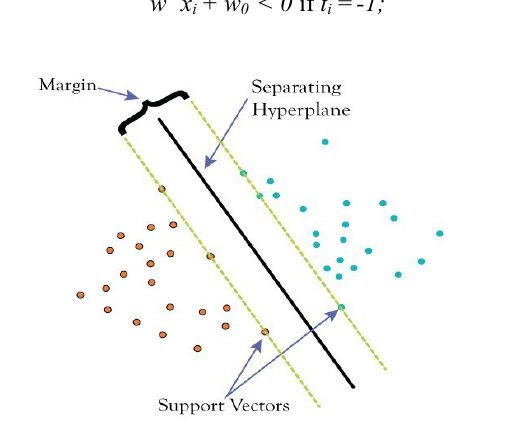
Figure 4. Support Vector